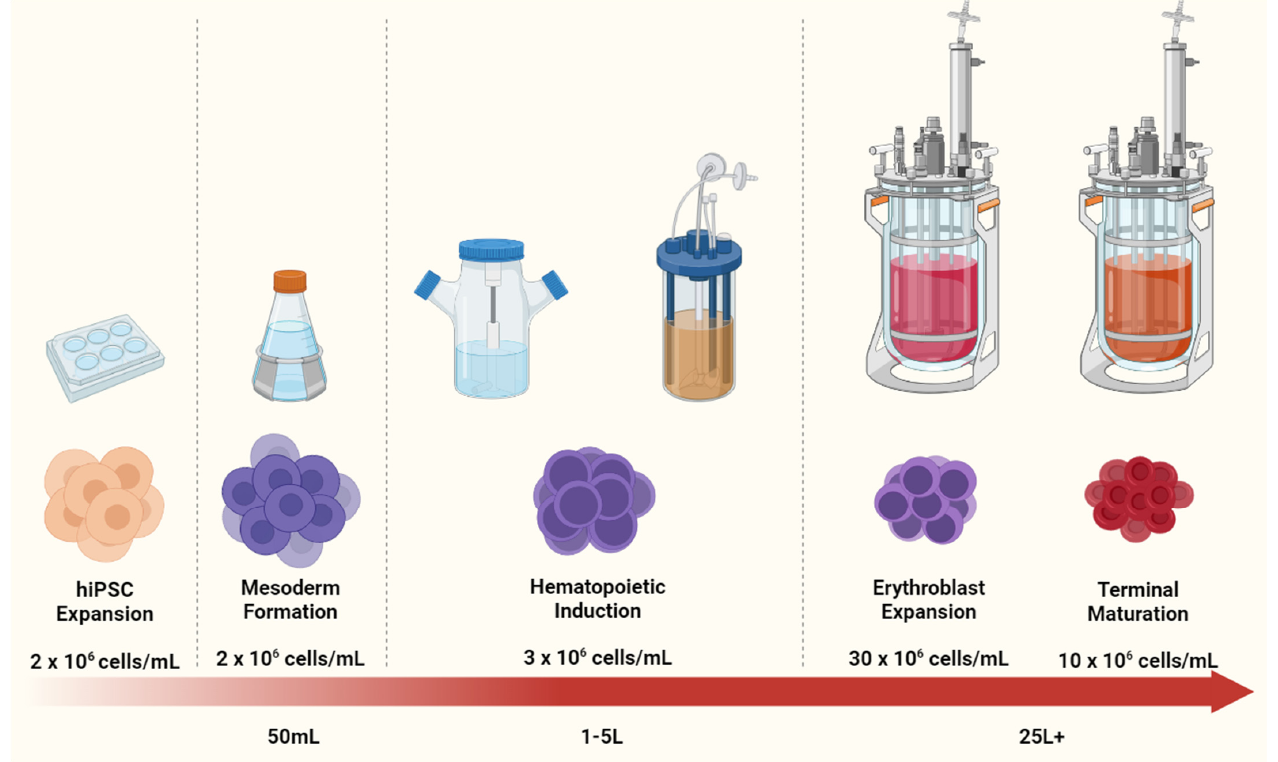
Figure 2. Scale-up of iPSC-RBC production in a suspension culture. Adapting each stage of the hematopoietic and erythroid specification in the suspension culture provides a starting point to achieve larger volumes and densities. A single 6-well ULA plate (left section) can provide enough cells for expansion and downstream differentiation in increasing volumes, from shake flasks to larger vessels, such as spinner flasks and lab-scale bioreactors (middle section), and eventually transitioning into large, controlled, stirred bioreactors (right section) for high-density erythroid culture and maturation of the cell product. Created with